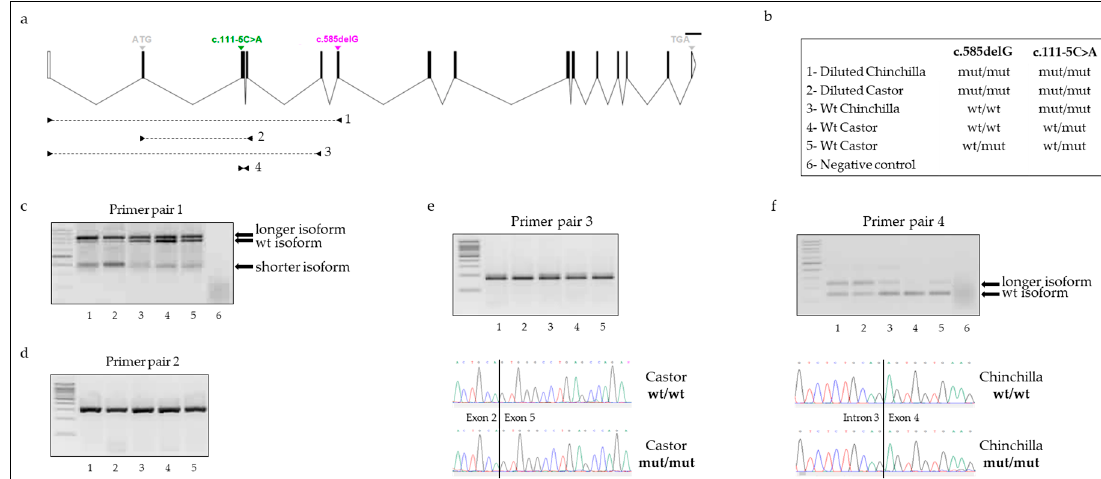
Figure 3. Identification of various MLPH isoforms. ( a ) Graphical representation of the rabbit MLPH gene with location of the c.111-5C>A and c.585delG variants. Locations of primer pairs used for RT-PCR are shown. ( b ) Five rabbits (3 Castor and 2 Chinchilla) were analyzed, and their phenotypes and genotypes at both variants are shown. For primer pairs 1 and 4, a negative control without reverse transcriptase was added since amplification might correspond to gDNA contamination. For all agarose gels, the order corresponds to numbers of animals. ( c ) Agarose gel using primer pair 1. ( d ) Agarose gel using primer pair 2. Primer pair 2 is specific to the wt MLPH isoform. ( e ) Results using primer pair 3. This primer pair is specific to the shorter MLPH isoform which is the MLPH transcript lacking exons 3 and 4 as shown on Sanger electropherograms. ( f ) Results using primer pair 4. PCR products were sequenced identifying a longer MLPH isoform containing intron 3 as shown on electropherograms.